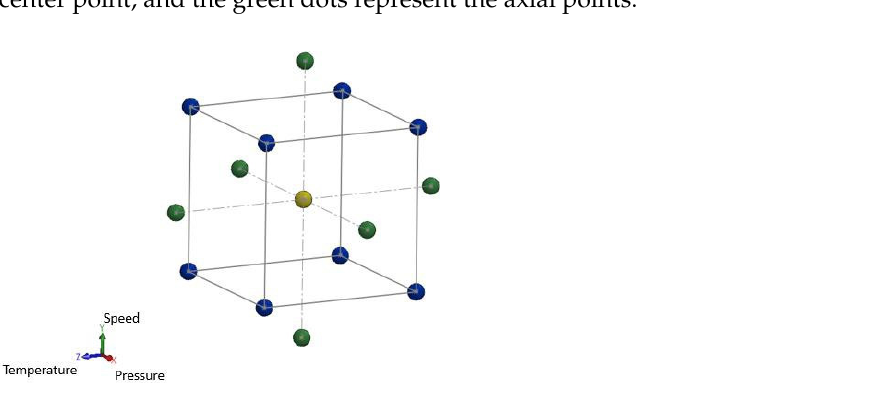
Figure 2. Circumscribed Central Composite Design (CCCD) for 3 factors: Temperature, Speed, and Pressure. and Pressure.